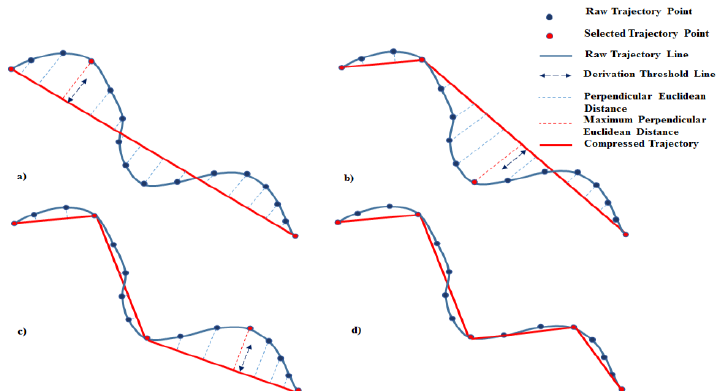
Figure 1 . Douglas Peucker compression algorithm (a-d)